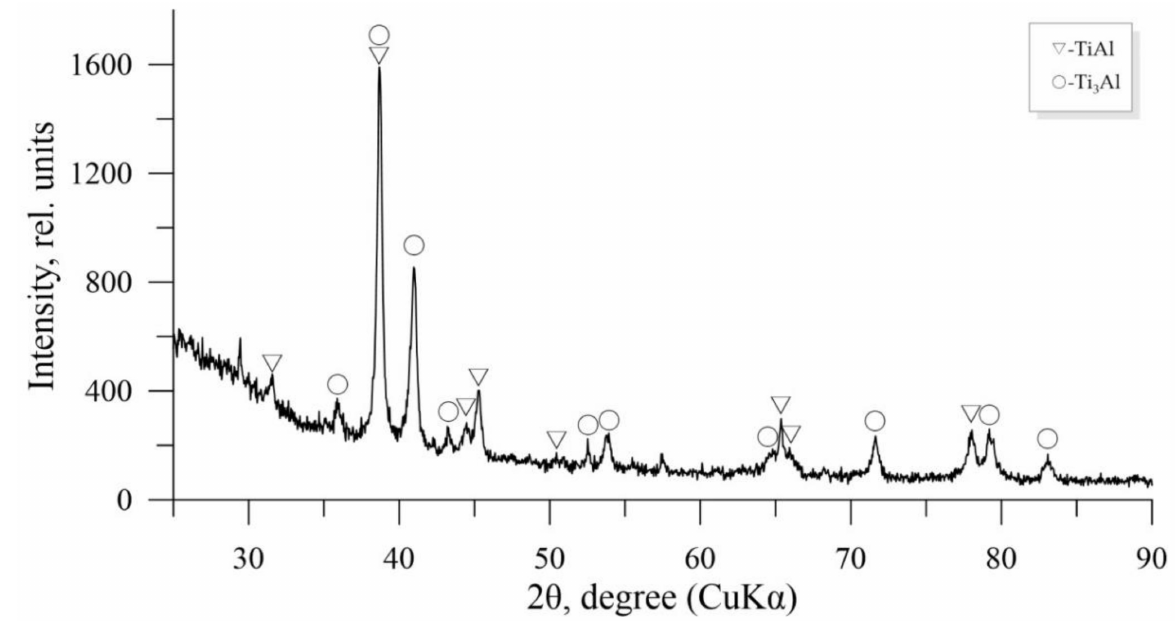
Figure 2. The X-ray diffraction (XRD) pattern of the sintered Ti-Al-Sc sample. When comparing the phase composition of the Ti-Al and Ti-Al-Sc systems (Table 1), it is obvious that the addition of scandium in the Ti-Al system changes the quantitative ratio of the resulted phases. In comparison with the initial sample of the Ti-Al system, after addition of Sc, the Ti 2 Al 5 phase was formed, but the Ti 2 Al phase was not obtained. Apparently, scandium dissolves in intermetallide phases, forming solid solutions, sub- stituting titanium [8]. For both systems Ti-Al and Ti-Al-Sc obtained by the HT method, composition of Ti-Al and Ti-Al-Sc alloys, synthesized using HT, and the results of the X-ray phase analysis are given in Table 1. Table 1. The phase composition of Ti-Al and Ti-Al-Sc